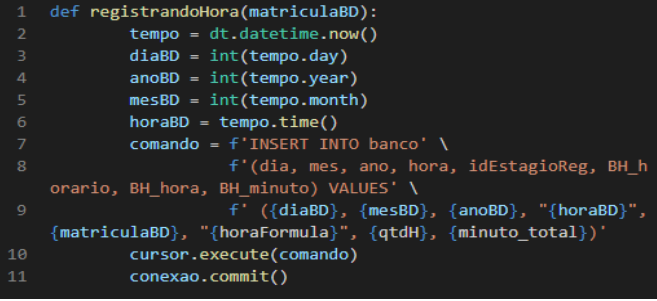
Figure 15: Function for time clocking recording.